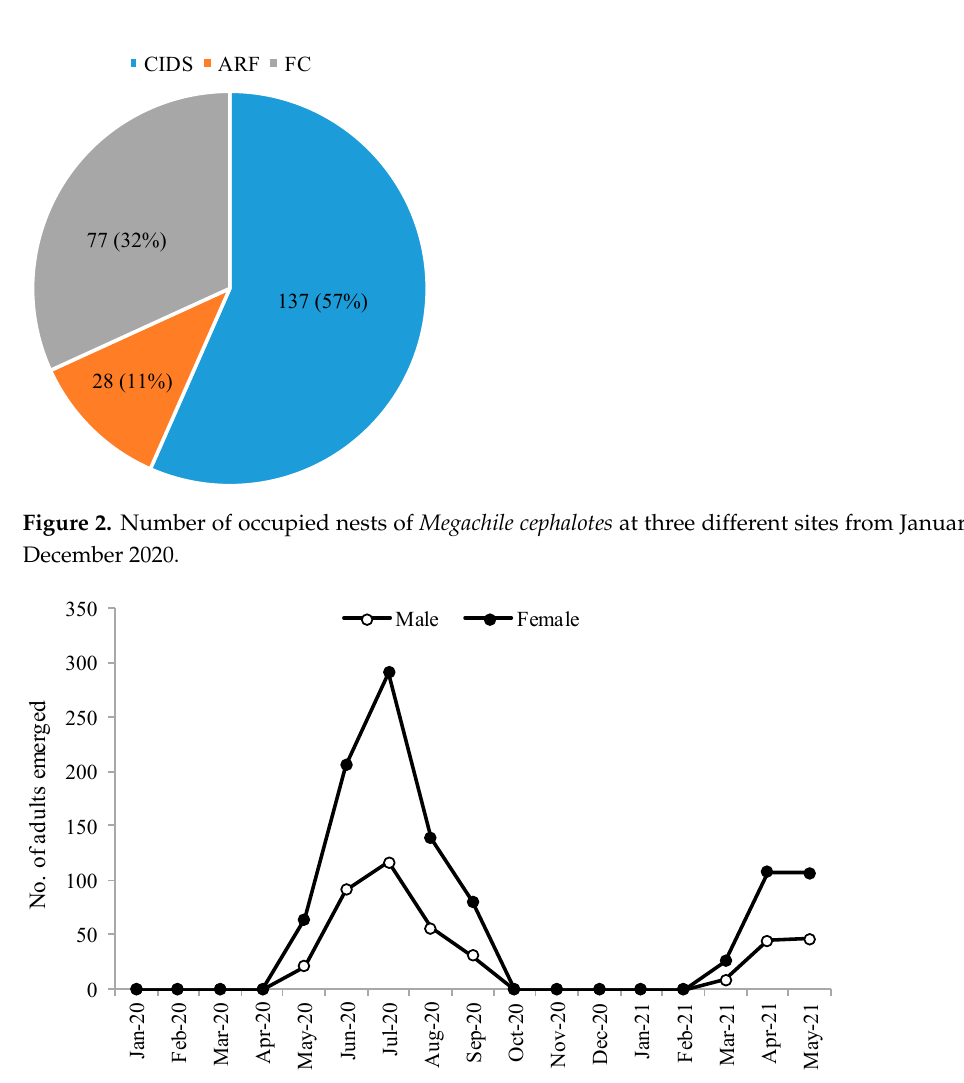
Figure 3. Emergence of male and female Megachile cephalotes from January 2020 to May 2021.